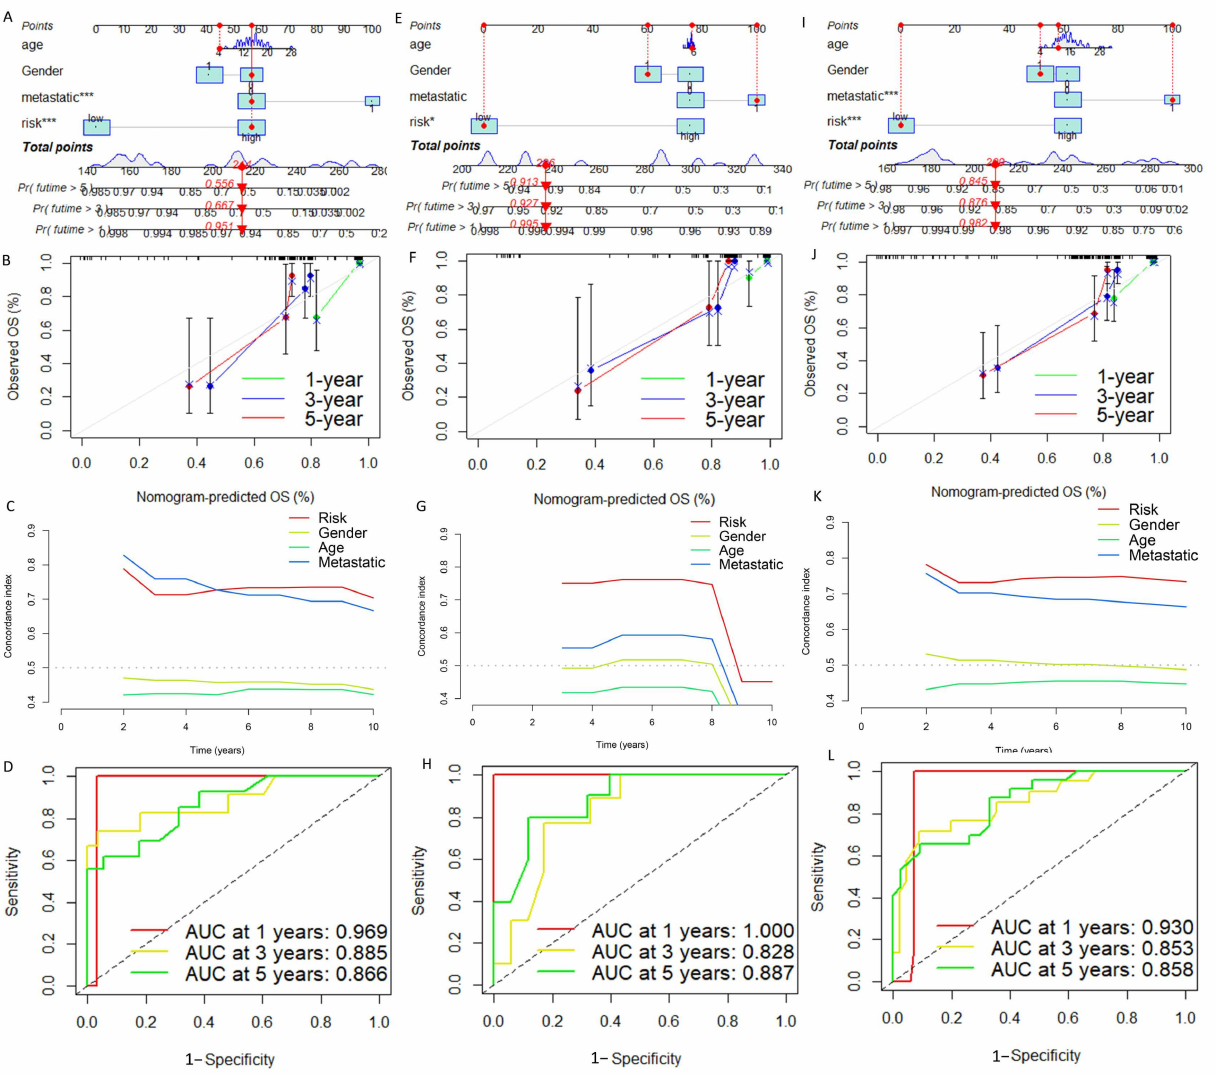
Figure 7. Construction and evaluation of a nomogram based on DGPS. Nomogram used to predict prognosis was constructed based on DGPS in the training set ( A ), test set ( E ), and entire cohort ( I ). Calibration curves of the nomogram in the training set ( B ), test set ( F ), and entire cohort ( J ). The C-index curves for assessing the discrimination ability of DGPS and other clinical characteristics at each time point in the training set ( C ), test set ( G ), and entire cohort ( K ). ROC curves of the nomograms at one, three, and five years in the training set ( D ), test set ( H ), and entire cohort ( L ). “*”represented “ p < 0.05”, “***”represented “ p <